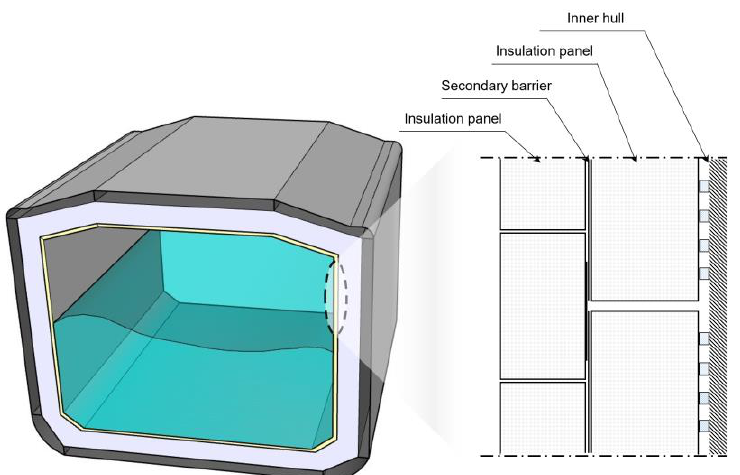
Figure 1. Mark III – type LNG insulation system. Figure 1. Mark III–type LNG insulation